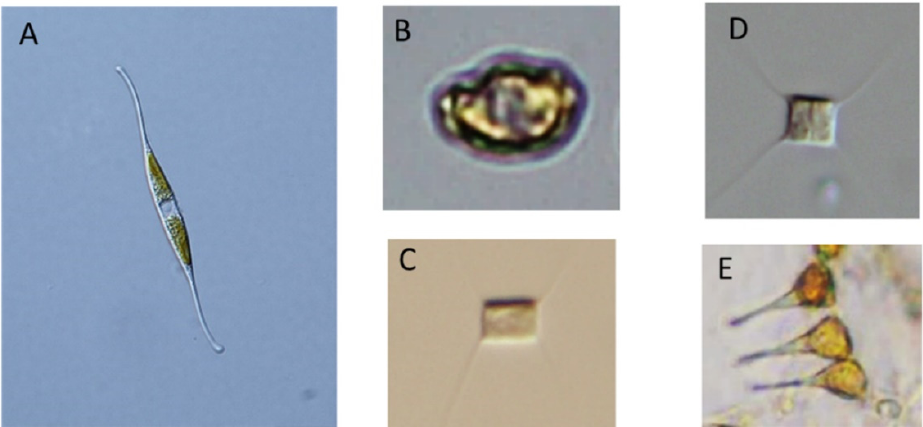
Figure 3. Microscopic images of the diatoms known to act as hosts for viruses: ( A ) Nitzschia reversa , host diatom for NitRevRNAV; ( B ) Heterosigma akashiwo host diatom for HaRNAV. ( C , D ) Chaetoceros tenuissimus host diatom for CtenRNAV II and CtenRNAV 01; ( E ) Asterionellopsis glacialis host diatom for AglaRNAV. Illustrations: ( A ) by Ken Toyoda from the Nippon Dental University, Tokyo, Japan; ( B – E ) by Yuji Tomaru from Fisheries Technology Institute, Fisheries Research and Education Agency, Hatsukaichi, Hiroshima, Japan.